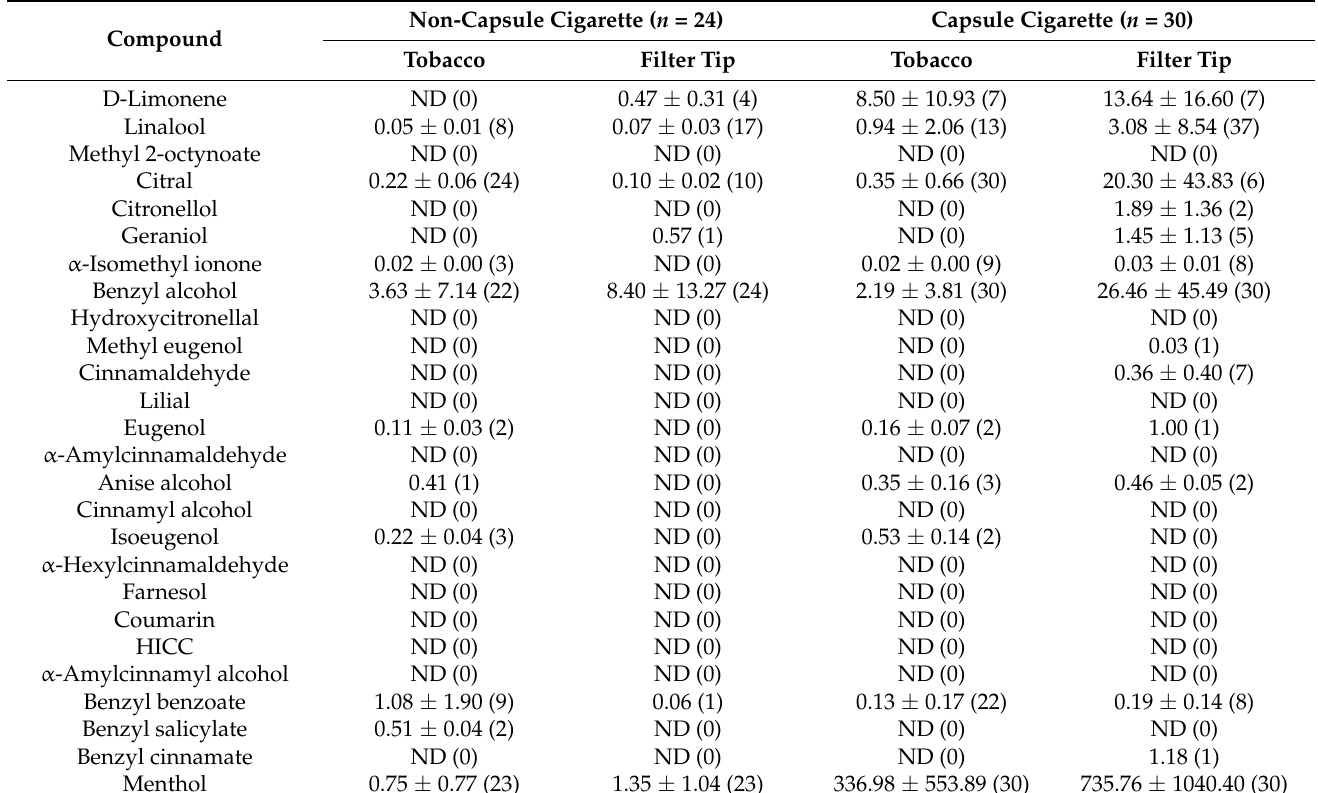
Table 3. Comparison of content ( µ g/cigarette) of flavoring agents in non-capsule cigarettes and capsule cigarettes. Non-Capsule Cigarette ( n = 24) Capsule Cigarette ( n = Compound